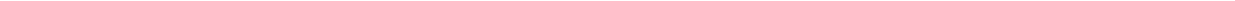
Fig. 3 Robust circadian rhythms in clock gene expression are maintained in non-24h LD housed mice. Representative brain sections a and quanti fi cation b of radioactive in situ hybridisation for Per1 expression in the SCN from mice housed in 24 h ( black ) or 22.5 h ( red ) conditions for 17 week. c Circulating corticosterone pro fi les were delayed relative to the LD cycle in mice housed under or 22.5h conditions. d Acrophase analysis of Per1 and corticosterone rhythms in 24 and 22.5h housed mice reveals consistent phase delay. e Pro fi ling of clock gene expression in peripheral tissues of mice housed in 24 or 22.5 h LD conditions for 17 weeks. f Acrophase analyses across genes and tissues (plotted relative to respective light cycle) demonstrates that synchronisation both within and across tissue clocks is maintained in non-24 h LD conditions. All data plotted mean ± SEM relative to the respective light cycle (24 or 22.5 h) and normalised to ZT0 of the 24 h LD group ( n = 4/time-point/group). ∗ Signi fi cant ( p < 0.05) difference in phase between 24 and 22.5 h pro fi les; a signi fi cant difference in amplitude or mesor between 24 and 22.5h LD conditions (sinusoidal waveform fi ts with F tests for shared characteristics). Scale bar in a = 3